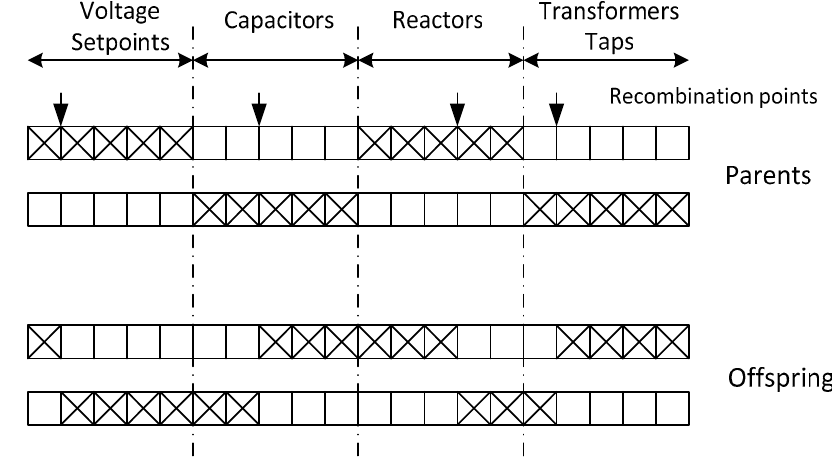
Figure 3. Recombination stage.